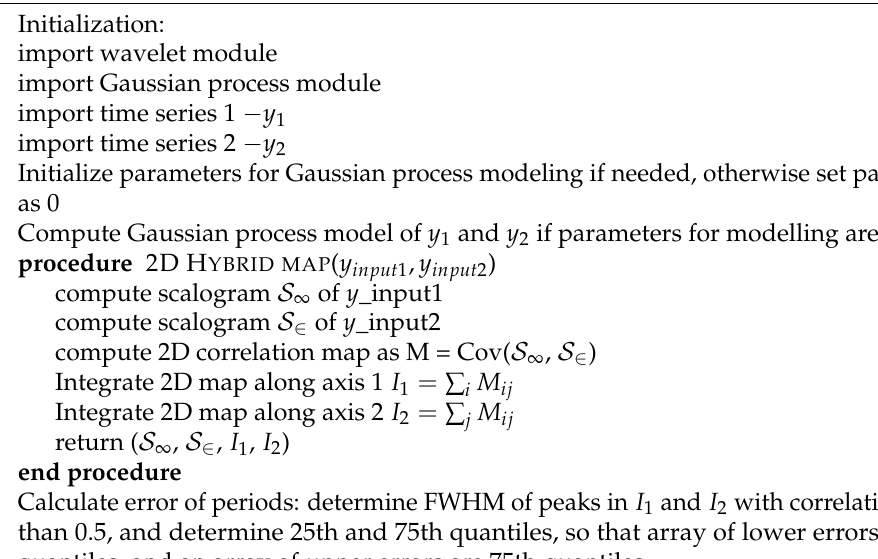
Algorithm A1 Pseudocode of 2D Hybrid